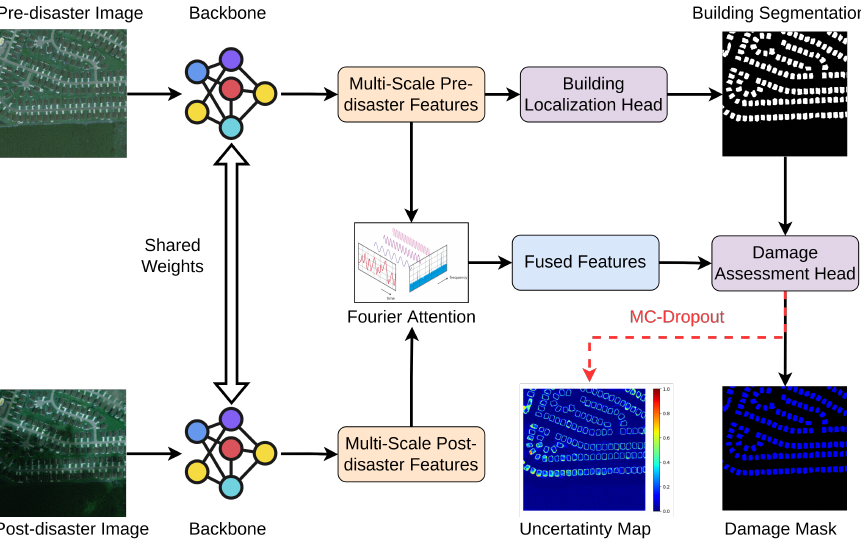
Figure 3. The illustration of efficient and uncertainty-aware building damage assessment